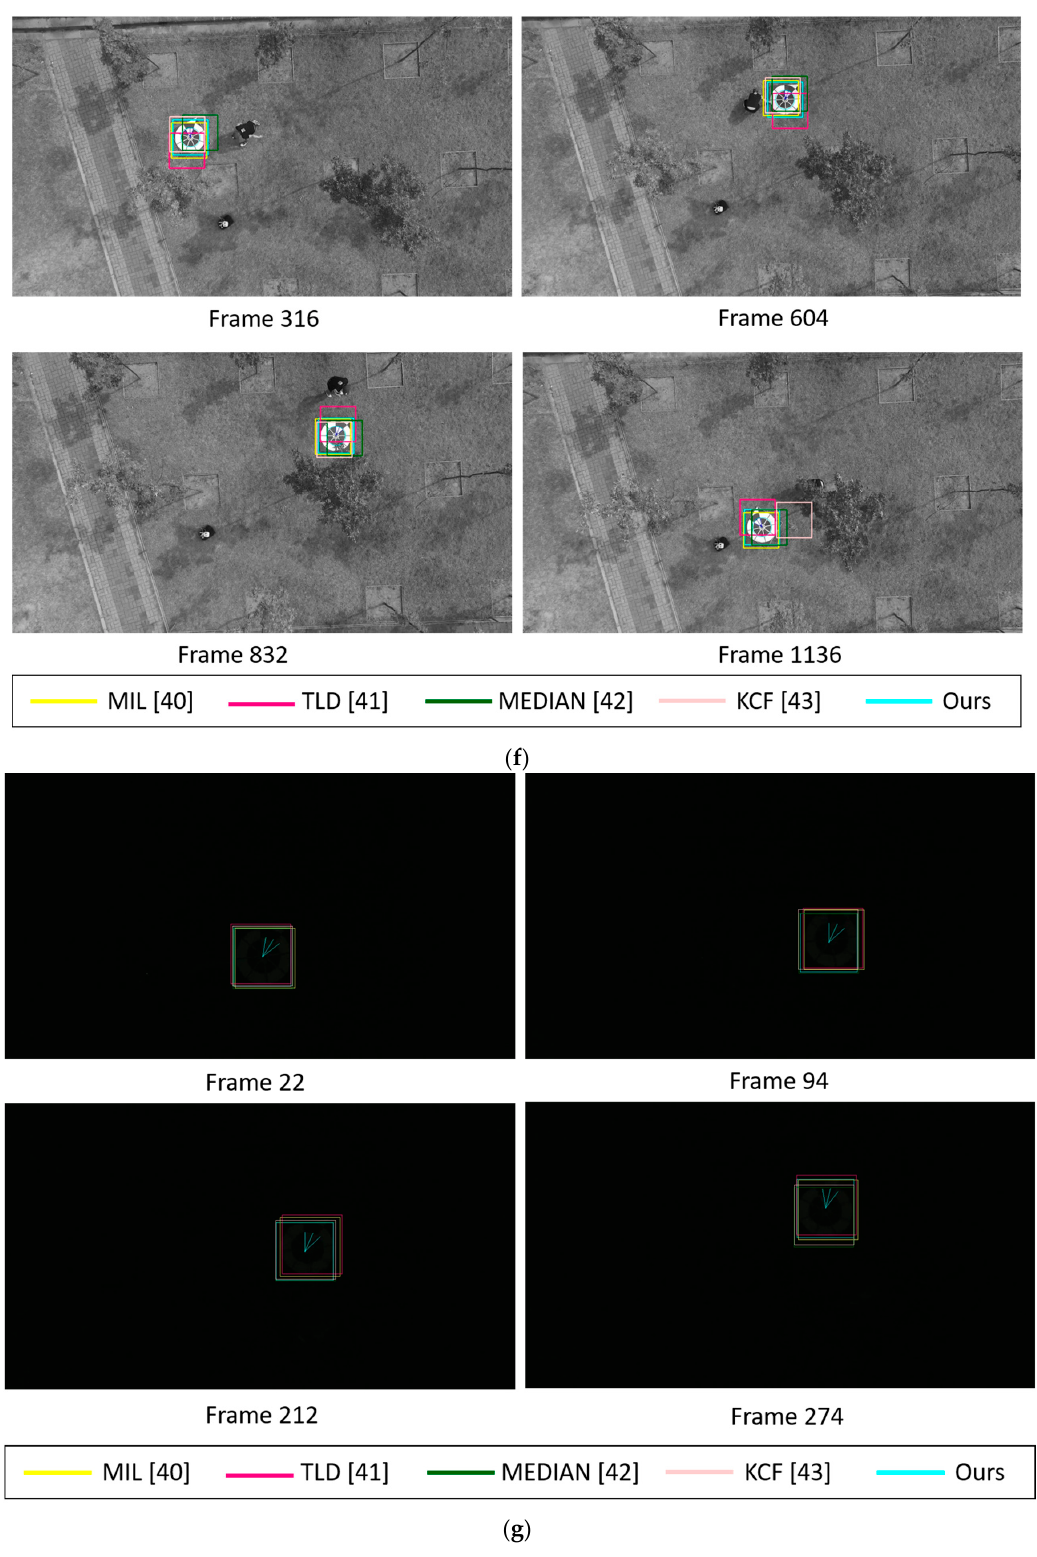
Figure 15. Marker detection examples by our method and previous methods using sub-database 2 including the videos captured ( a , b ) in the morning, ( c , d ) in the afternoon, ( e , f ) in the evening, and ( g ) at night.